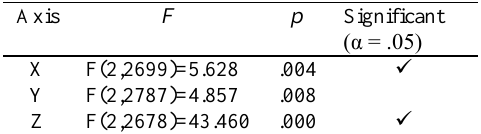
Table 6. Significance of the effect of head position on accuracy